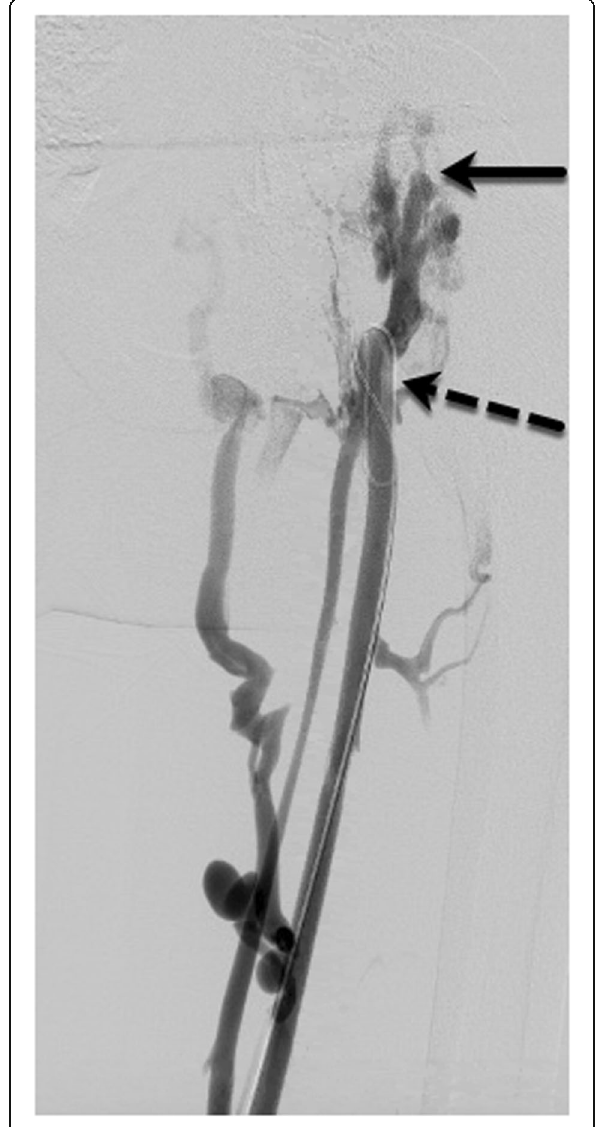
Fig. 4 14 y/o M with chronic venous occlusion of the right lower extremity. Solid arrow marks the venous cap: the antegrade entrance to the occluded vessel lumen. Dashed arrow marks the wire looped within the central lumen of the patent portion of the peripheral